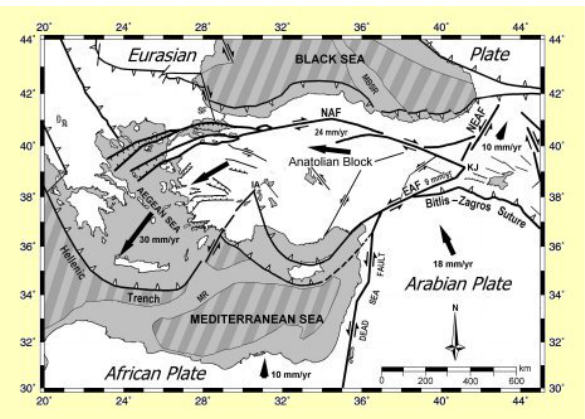
Fig. 2. Major faulting system in the Simav region (AFAD,